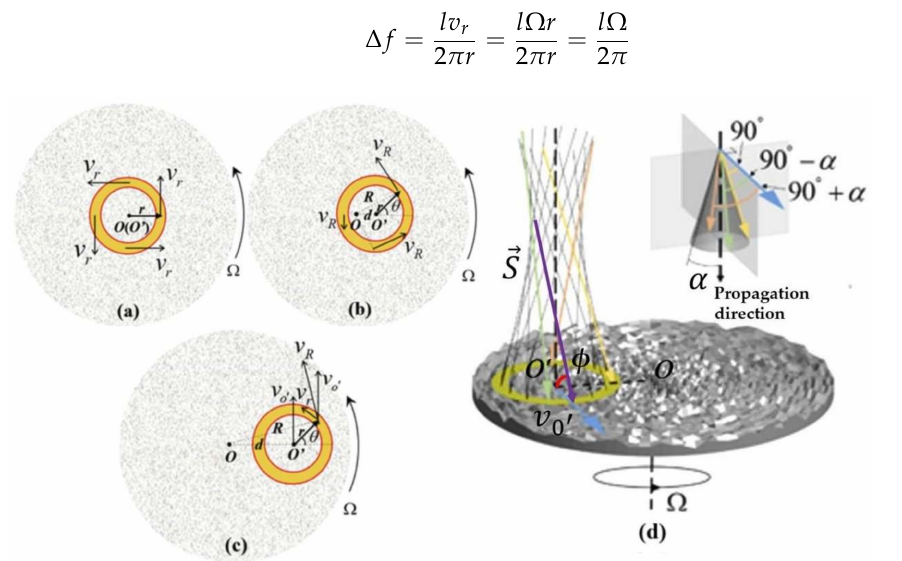
Figure 14. Diagram of misaligned illumination with different offsets, and the corresponding decom- position of velocity vector. ( a ) The center of the OAM light beam coincides with the rotation center of the object. ( b ) With a small misalignment. ( c ) With a large misalignment. ( d ) The relationship between the Poynting vector of the vortex beam and the velocity vector of rotating object and φ is the angle between them. Adapted with permission from ref.